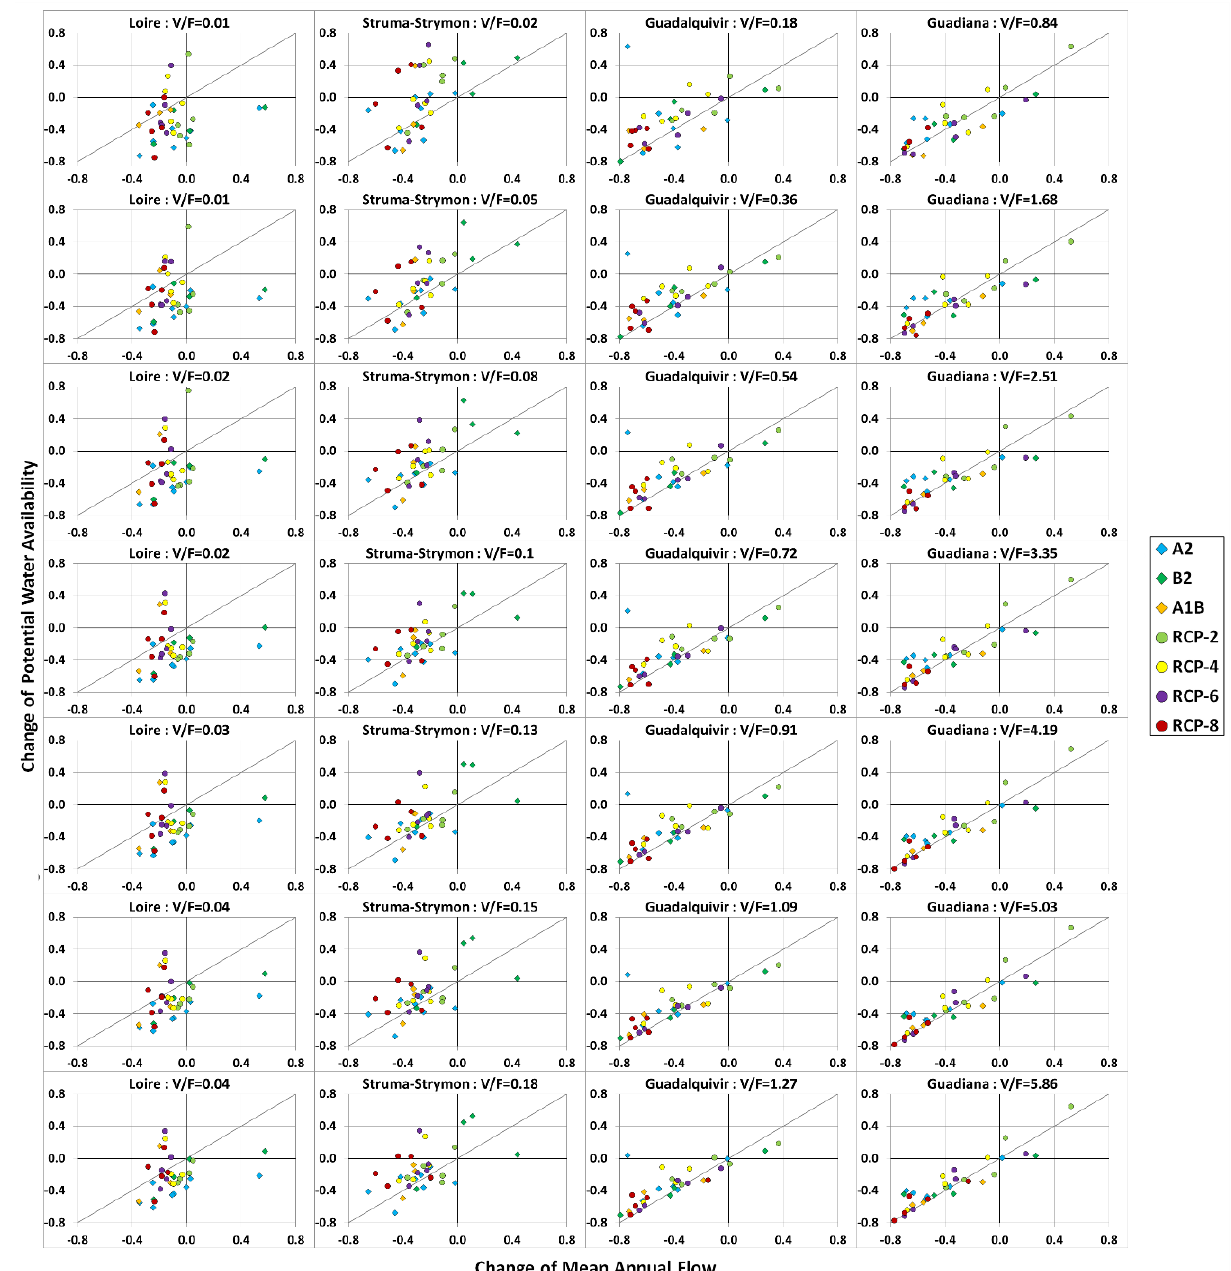
Figure 9. Comparison of the estimated changes in Mean Annual Flow ( ∆ F) and the estimated changes in Potential Water Availability ( ∆ PWA) for 25%, 50%, 75%, 100%, 125%, 150% and 175% (in rows, ordered from top to bottom) for four representative basins of the study: Loire (left column), Struma-Strymon (center-left column), Guadalquivir (center-right column) and Guadiana (right column).